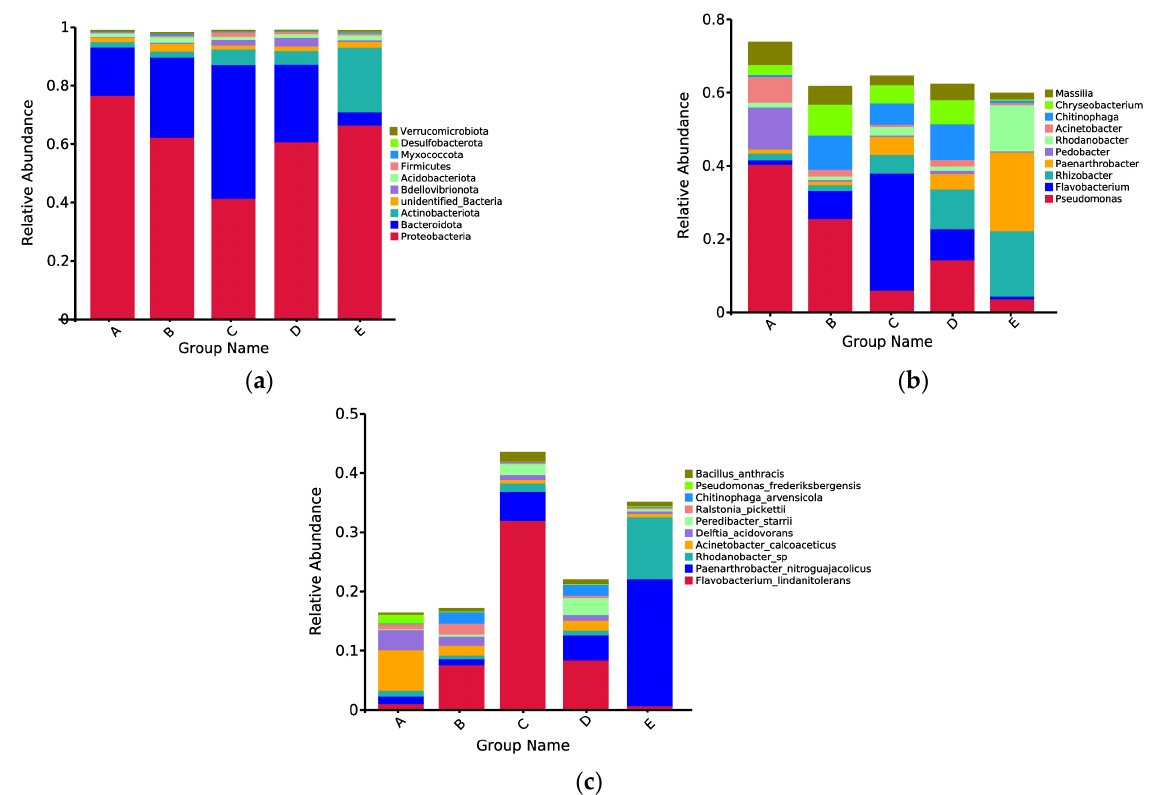
Figure 6. The relative abundance of dominant bacteria at phylum ( a ), genus ( b ), and species ( c ) levels; the abscissa is the plastic degradation process at five time points, and the ordinate is the relative abundance of each dominant taxa at the phylum level.